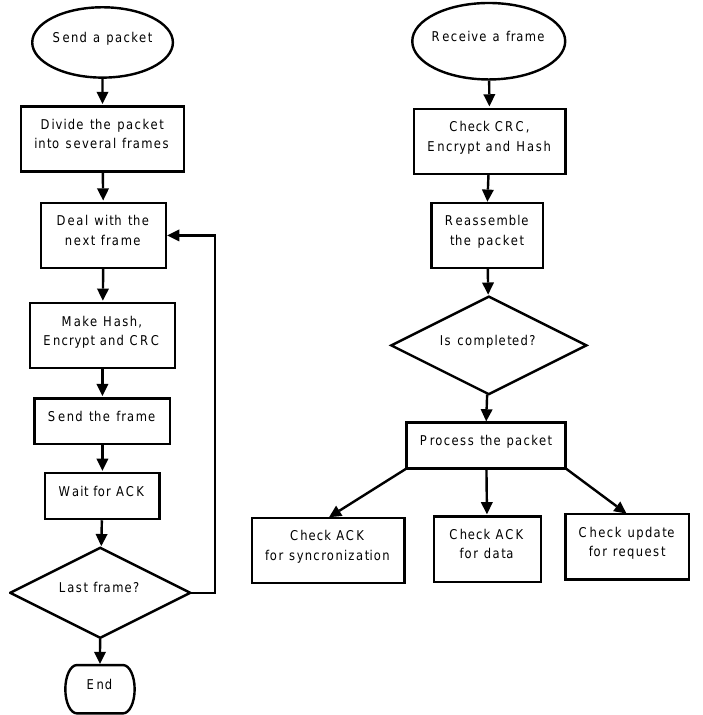
Figure 11. Flowchart showing the required task to send and receive frames using GPRS